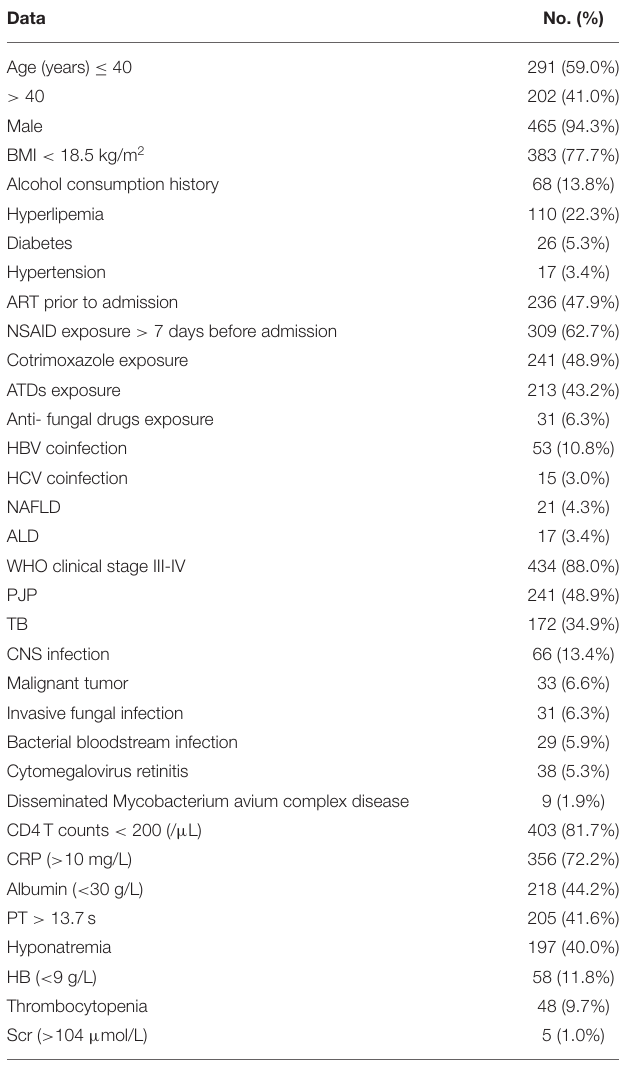
TABLE 1 | Baseline clinical and laboratory characteristics of 493 hospitalized HIV